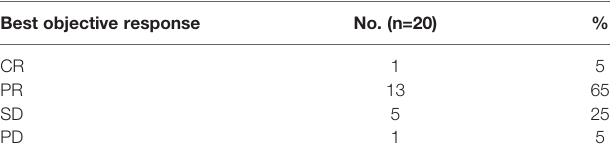
TABLE 2 | Ef fi cacy data (RANO criteria).